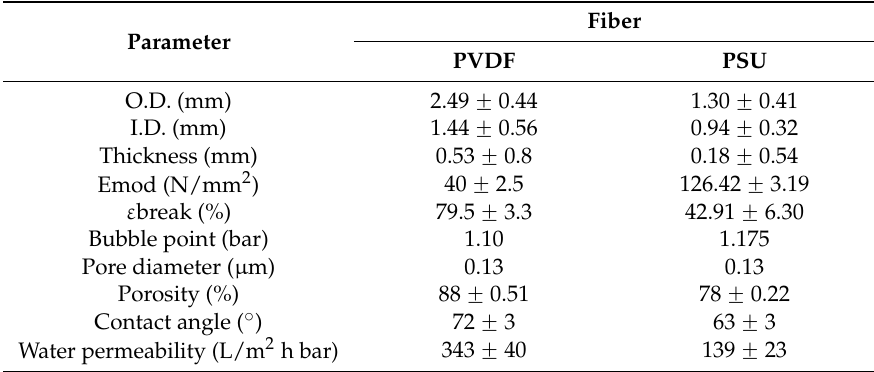
Table 2. Main properties of PVDF and PSU